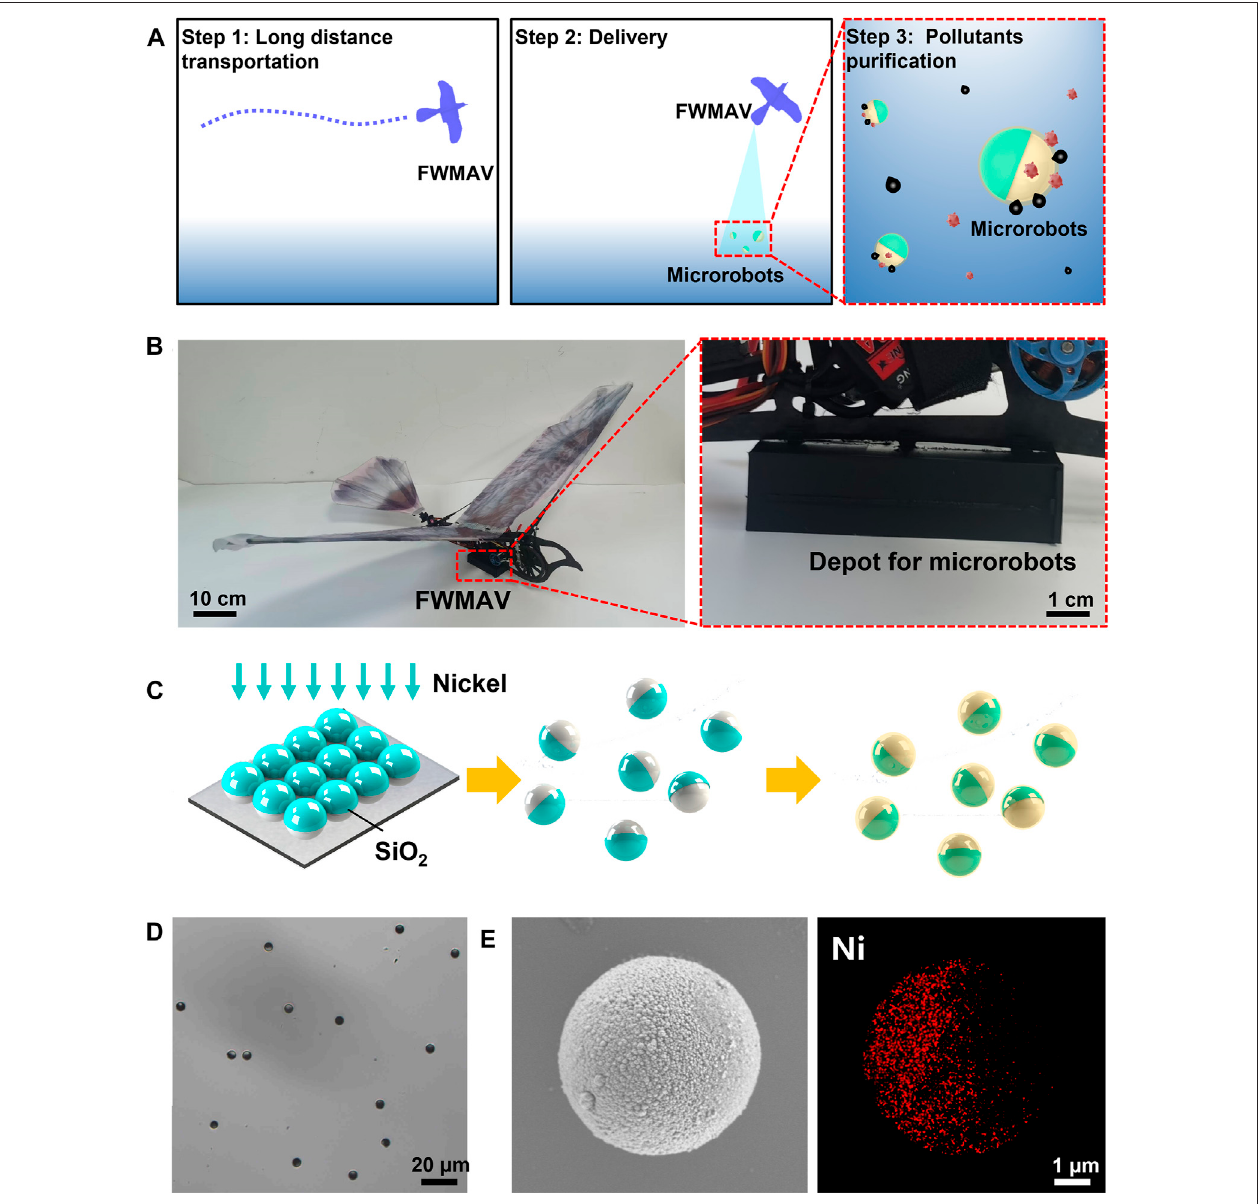
FIGURE 1 | Design and preparation of the smart robot platform. (A) Schematic of the smart robot platform composed of an FWMAV and Janus microrobots. (B) Structure of an FWMAV. The depot for microrobots was fi xed in the barycenter of the FWMAV. (C) Fabrication of Janus microrobots. (D) Optical microscopy image, (E) SEM image, and corresponding EDX mapping of oil-sorption Janus microrobots.